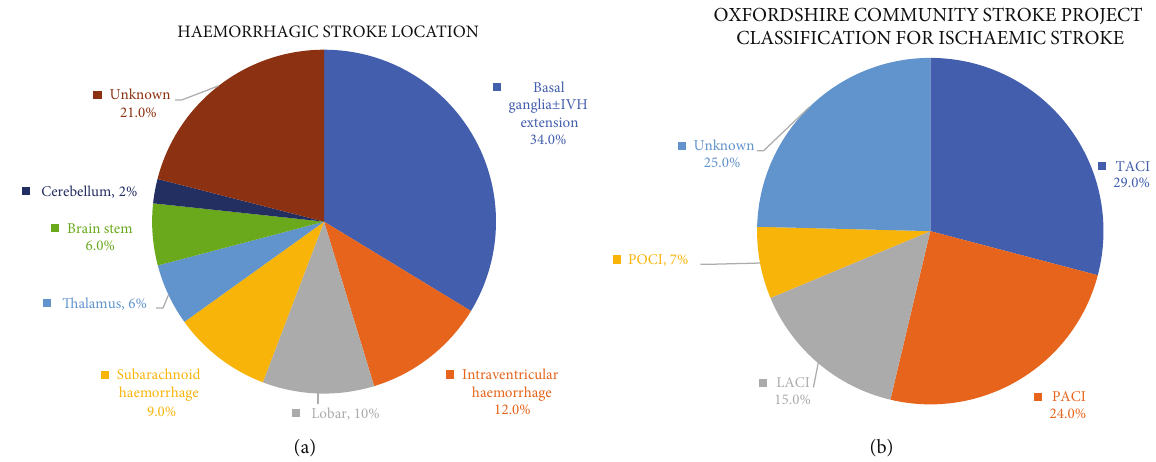
Figure 2: (a) Abbreviations: IVH: intraventricular haemorrhage. (b) Abbreviations: LACI: lacunar infarct; PACI: partial anterior circulation infarct; POCI: posterior circulation infarct; TACI: total anterior circulation